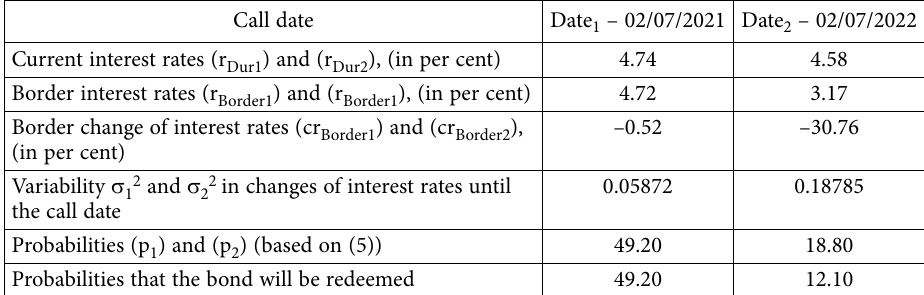
Table 5. Probabilities that on Date 1 and Date 2 the bond will be